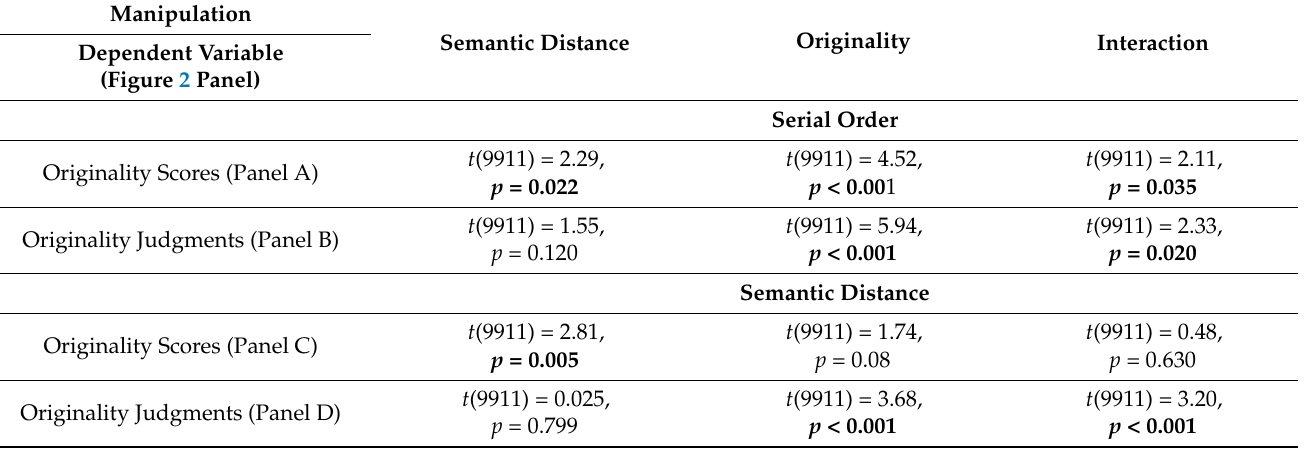
Table 3. Regression results of comparisons among the four groups in the β of the biasing factors (interaction effects between the group and the cue) that appear in Figure 2 1 . Manipulation Semantic Distance